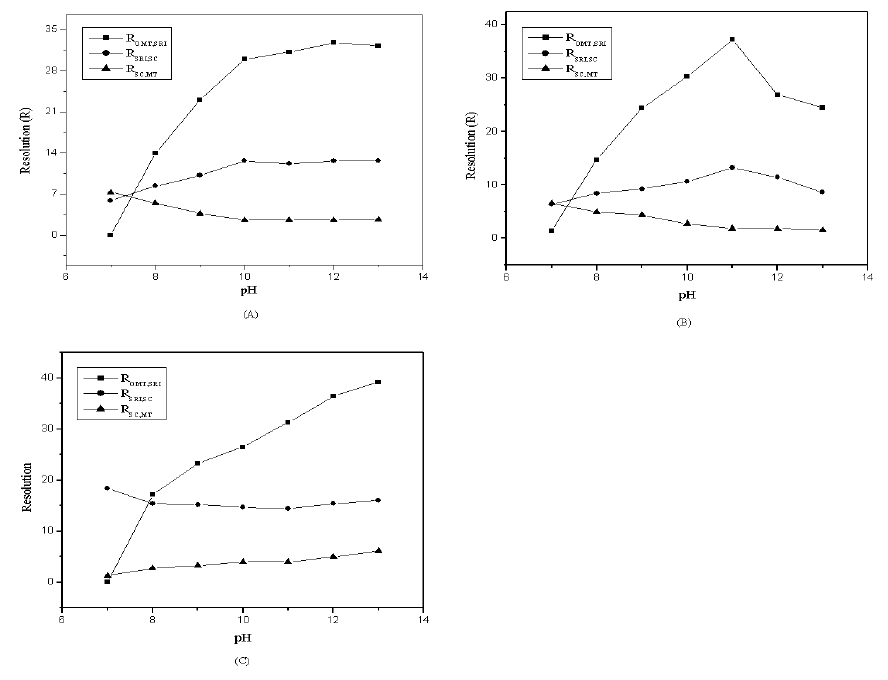
] (A) , [BMIM][BF ] (B) and [OMIM][BF 4 4